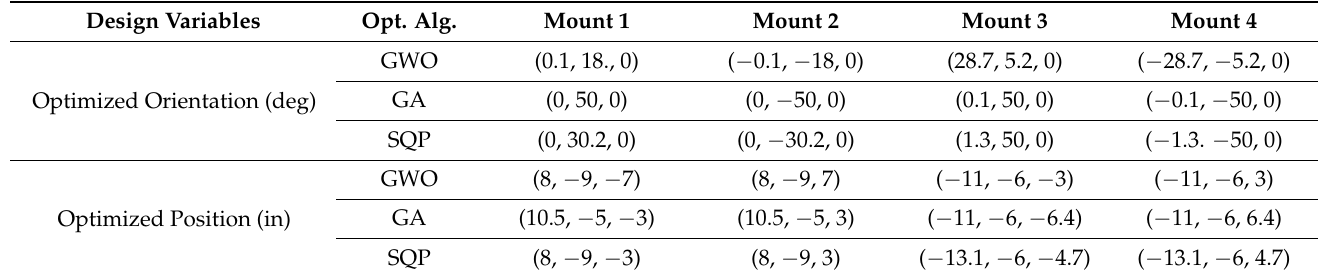
Table 10. Optimization results for mounts’ positions and orientations (12-DOF model— combined